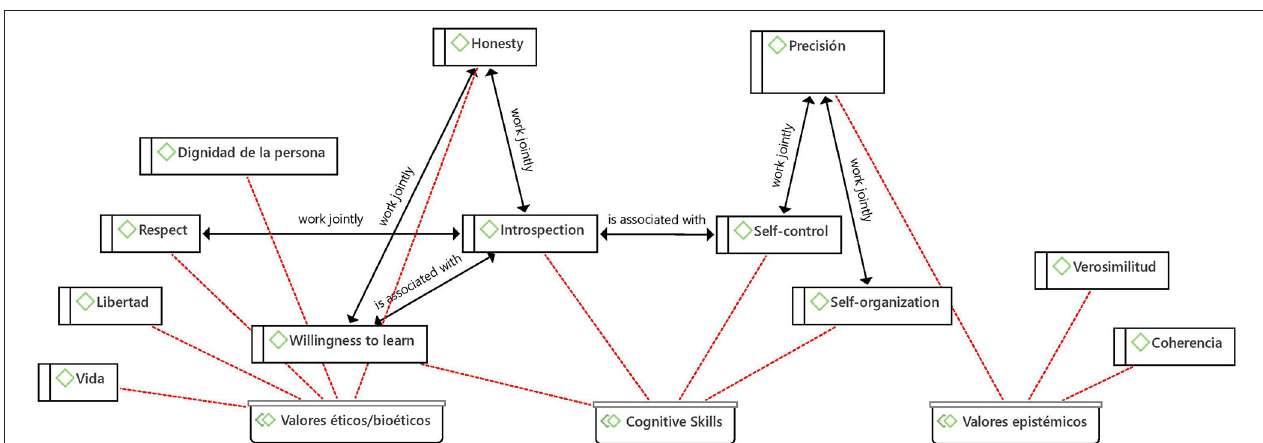
FIGURE 8 | Net between axiology and